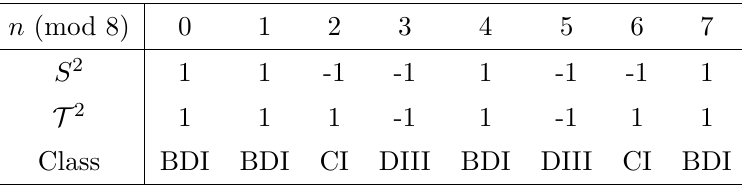
Table 1 . Symmetry classes of uncolored Hamiltonians for varying n and for d =